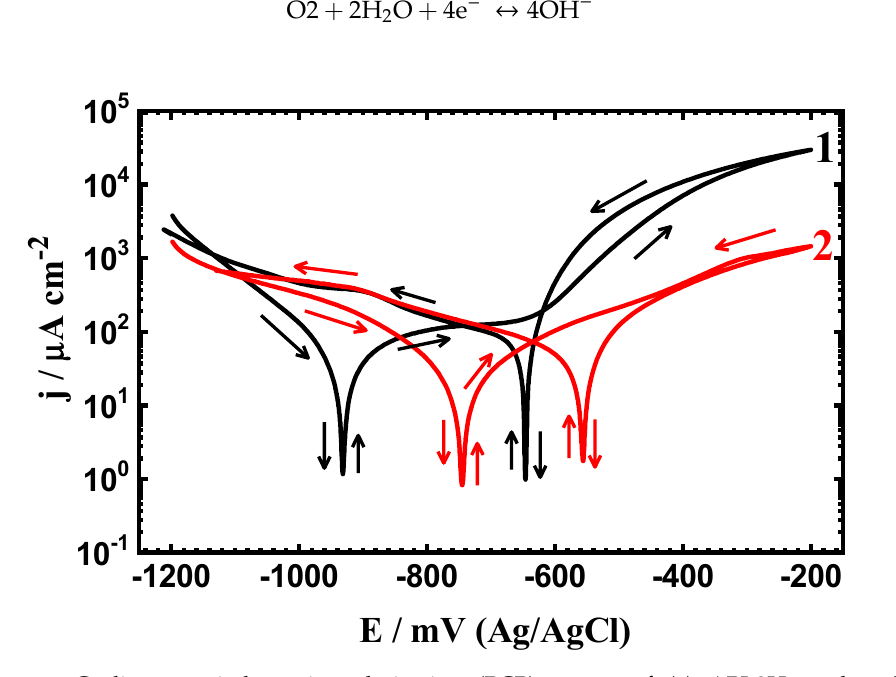
Figure 1. Cyclic potentiodynamic polarization (PCP) curves of ( 1 ) API-2H steel and ( 2 ) 75%Cr 3 C 2 − 25%NiCr coated API-2H steel after exposure in 4% NaCl solution for 1 h.